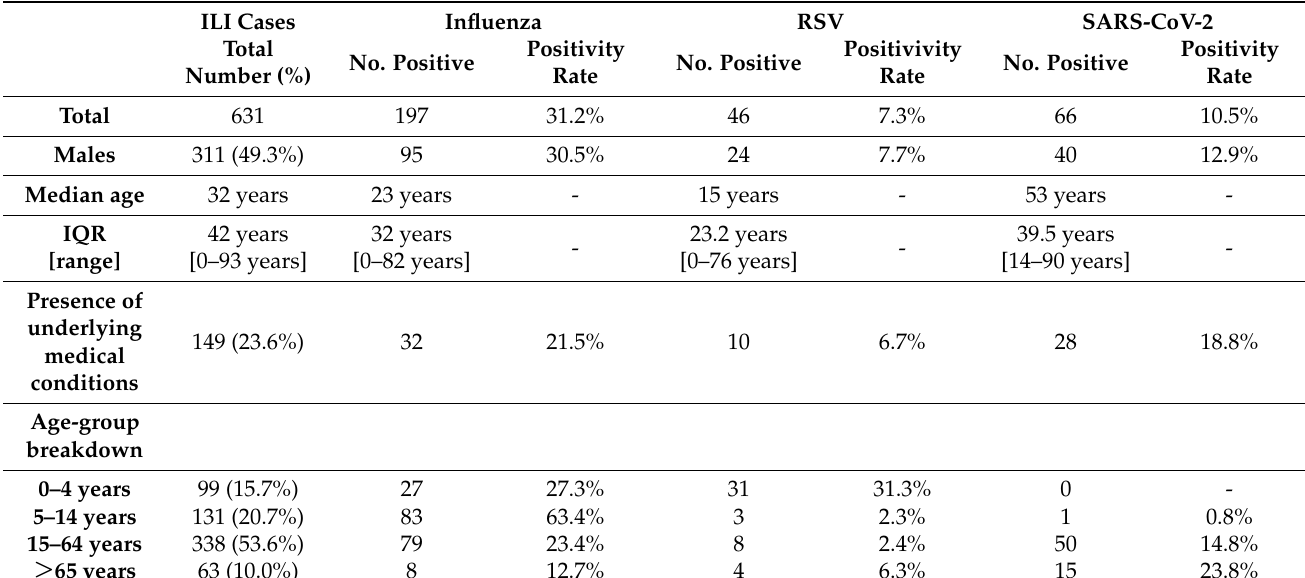
Table 1. Total number and proportion of the main characteristics of Influenza-like illness (ILI) cases: number and positivity rates of influenza virus-positive, RSV-positive, and SARS-CoV-2-positive cases overall, and by sex, presence of underlying conditions, and age group. Median age and inter-quartile range (IQR) of all ILI patients and positive cases are also reported. Footnote: Of the 197 influenza virus-positive samples, 23% ( n = 46) tested positive for A(H1N1)pdm09, 22% ( n = 43) for A(H3N2), and 55% ( n = 198) for influenza B virus, all belonging to B/Victoria